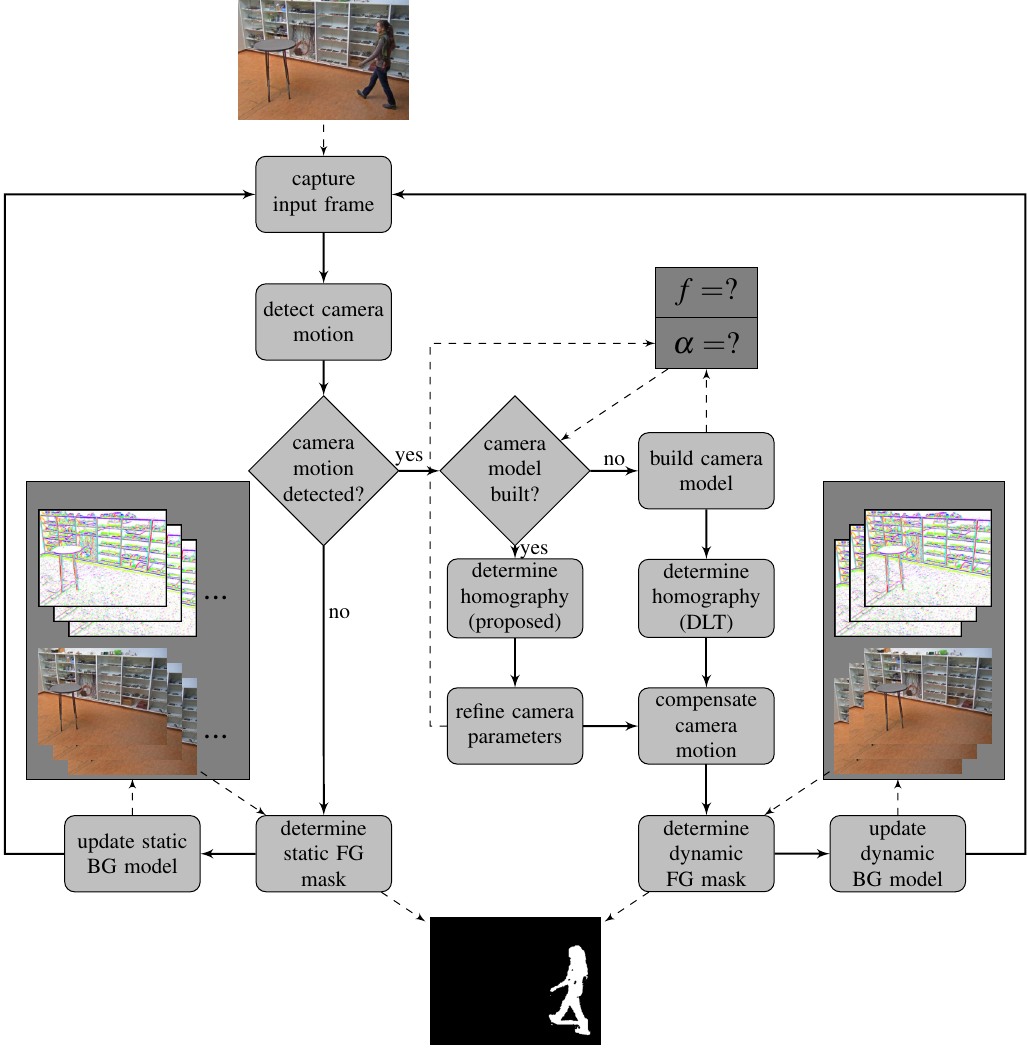
Figure 4. Flowchart demonstrating the internal operation of the foreground–background segmentation algorithm. The camera model is presented in Sections 3 and 4. Building the camera model is described in detail in Section 5. The estimation of the homography and camera parameter refinement are treated